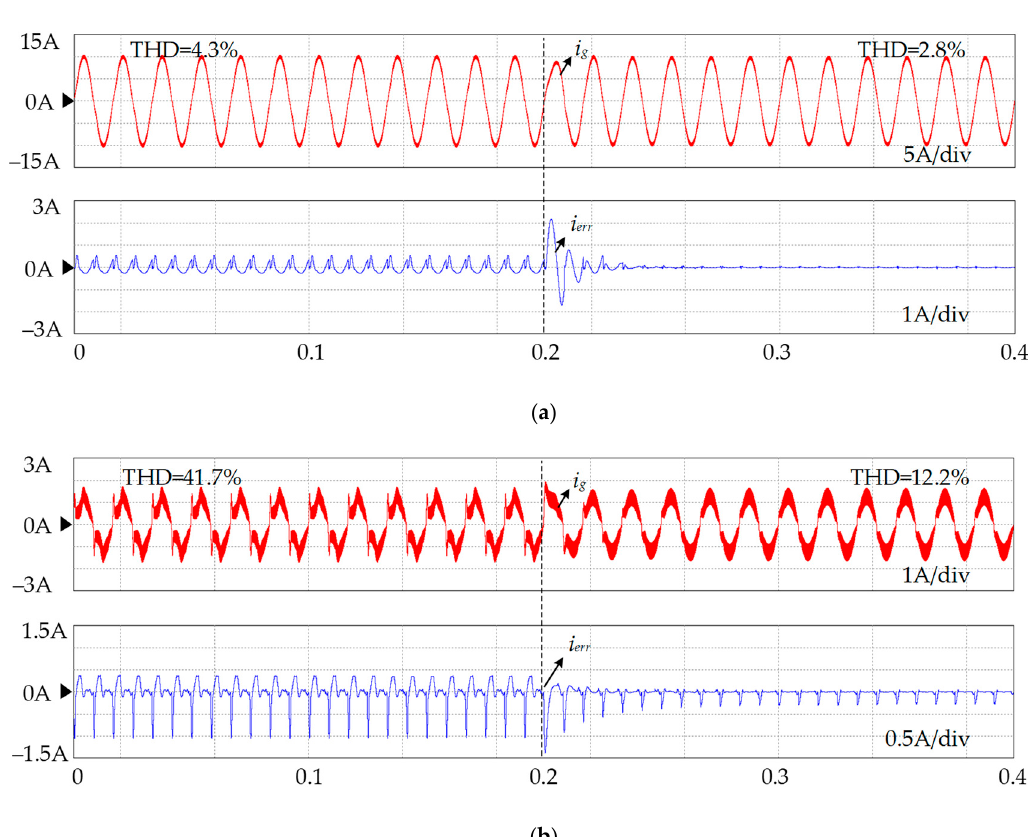
Figure 11. Simulation results applying repetitive controller at 0.2 s in buck mode: ( a ) Input current and current error at load = 800 W; ( b ) Input current and current error at load = 100 W.